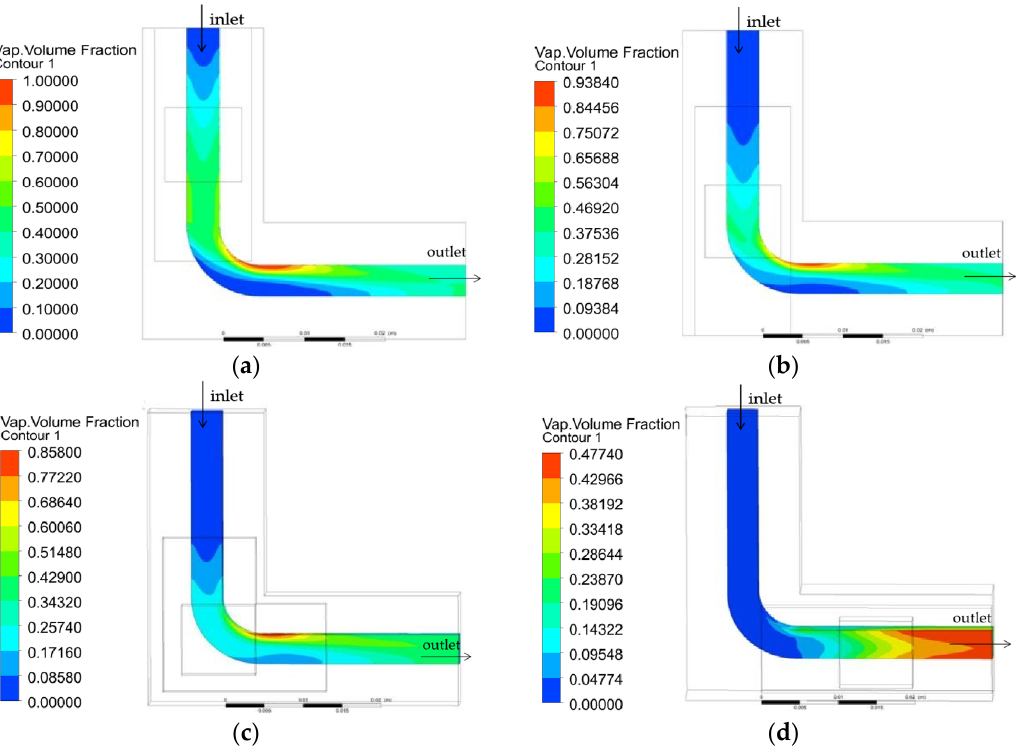
Figure 12. Vapor-phase distribution when the heat source is set: ( a ) in front of the bend; ( b ) near the bend; ( c ) just above the bend; ( d ) behind the bend. bend; ( c ) just above the bend; ( d ) behind the